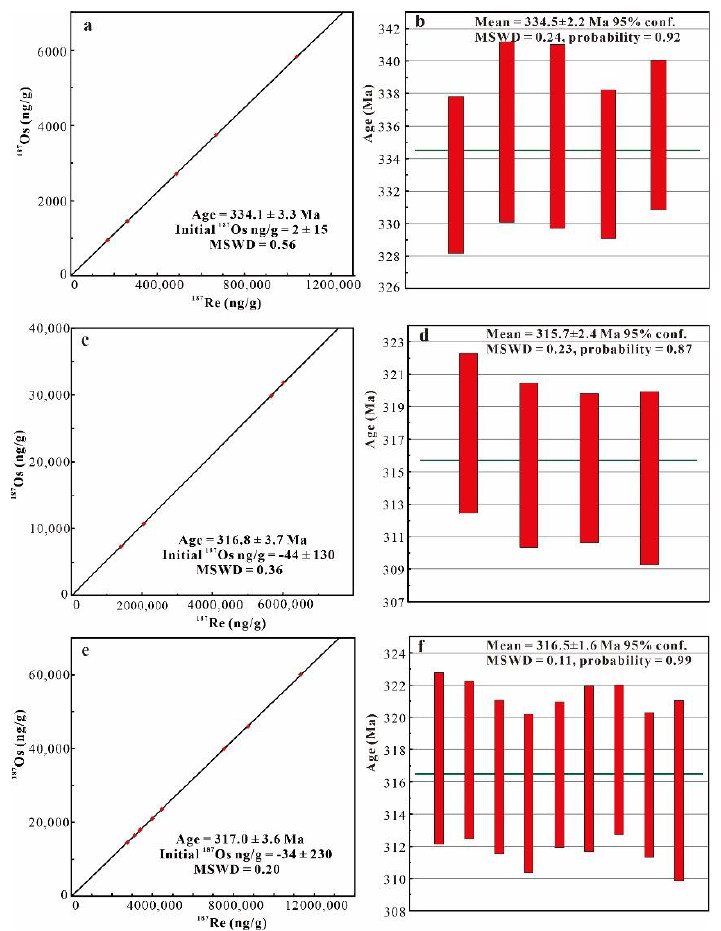
Figure 7. Molybdenite Re–Os isotope analyses for the Tuwu–Yandong porphyry Cu belt. ( a , c , e ) Isochron ages of the molybdenite from the Tuwu, Linglong, and Chihu porphyry Cu deposits, respectively. ( b , d , f ) Weighted average Re–Os model ages of analyses from the Tuwu, Linglong, and Chihu porphyry Cu deposits, respectively.